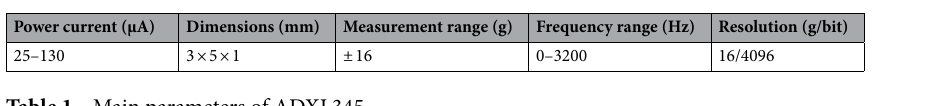
Table 1. Main parameters of